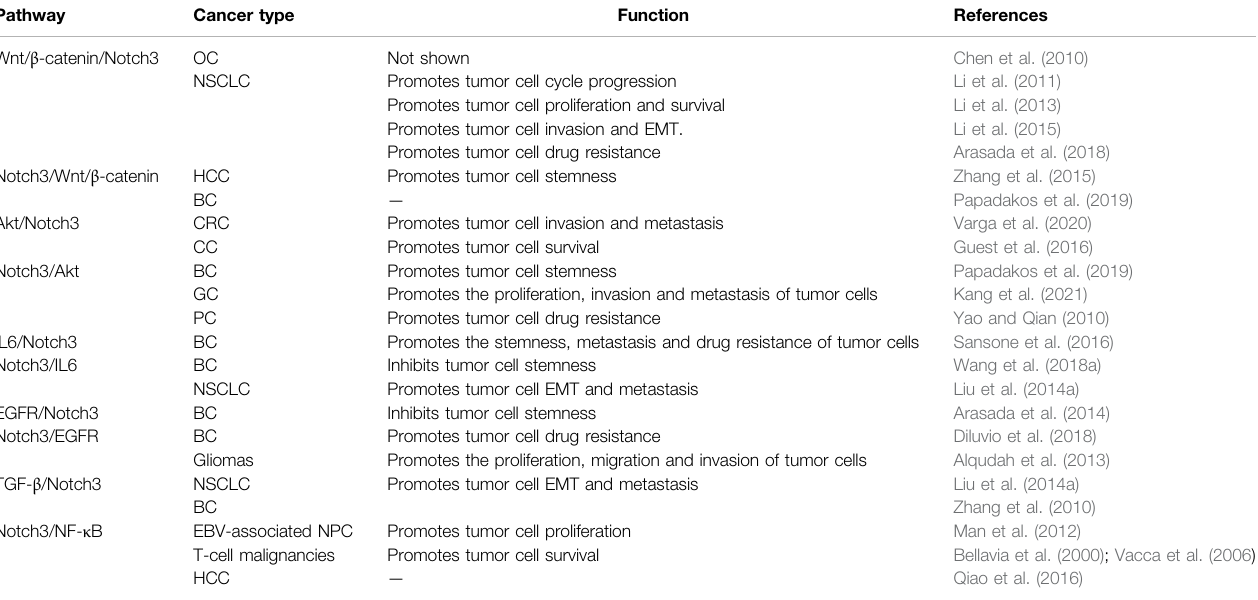
TABLE 3 | The associations between Notch3 signaling and other signaling pathways. Pathway Cancer